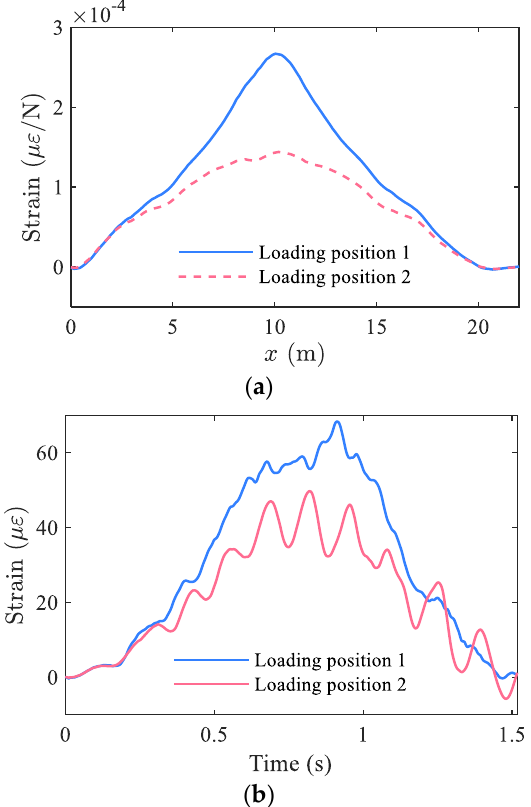
Figure 6. ( a ) Strain influence line of the second girder at bridge mid-span. ( b ) Typical bridge strain response (5-axle truck, 20 m/s, RSC: class B).